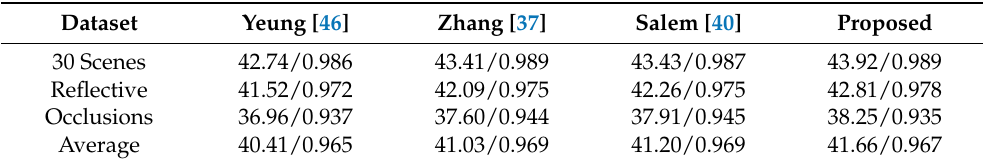
Table 4. The proposed model’s numerical comparison (PSNR/SSIM) to reconstruct 8 × 8 out of 2 × 2 views: extrapolation 2.